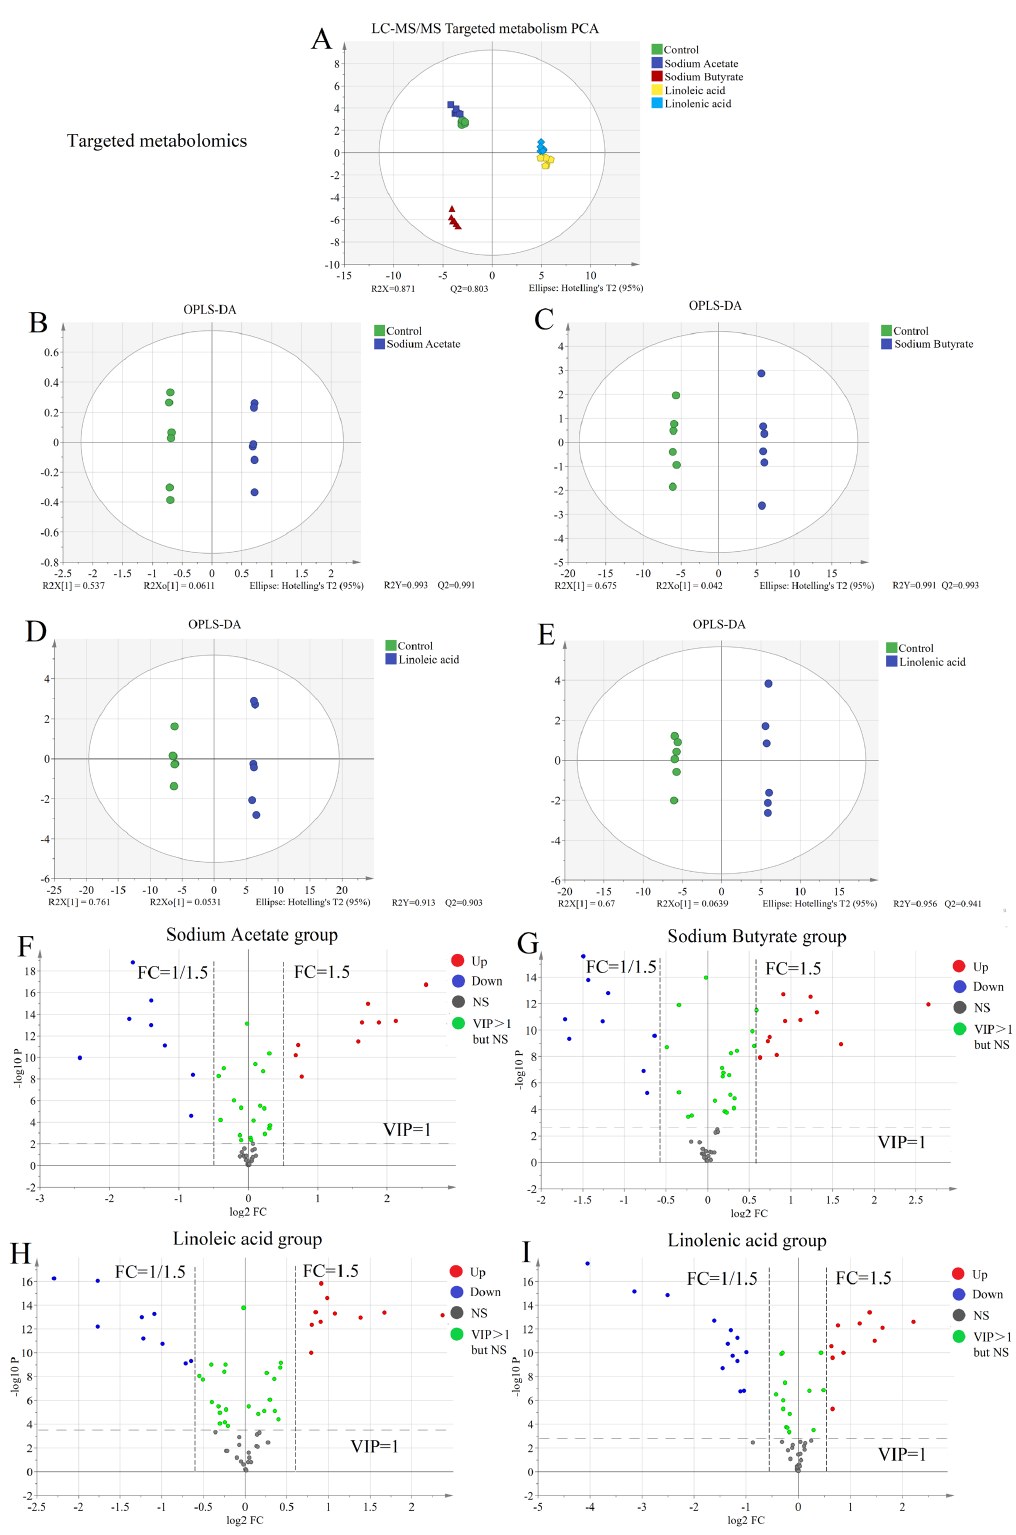
Figure 5. Screening differential metabolites between the control and the four fatty acid groups based on targeted metabonomics: ( A ) PCA plots; ( B – E ) OPLS-DA plots; ( F – I ) volcano plots of sodium acetate group, sodium butyrate group, linoleic acid group, and linolenic acid group compared with the control